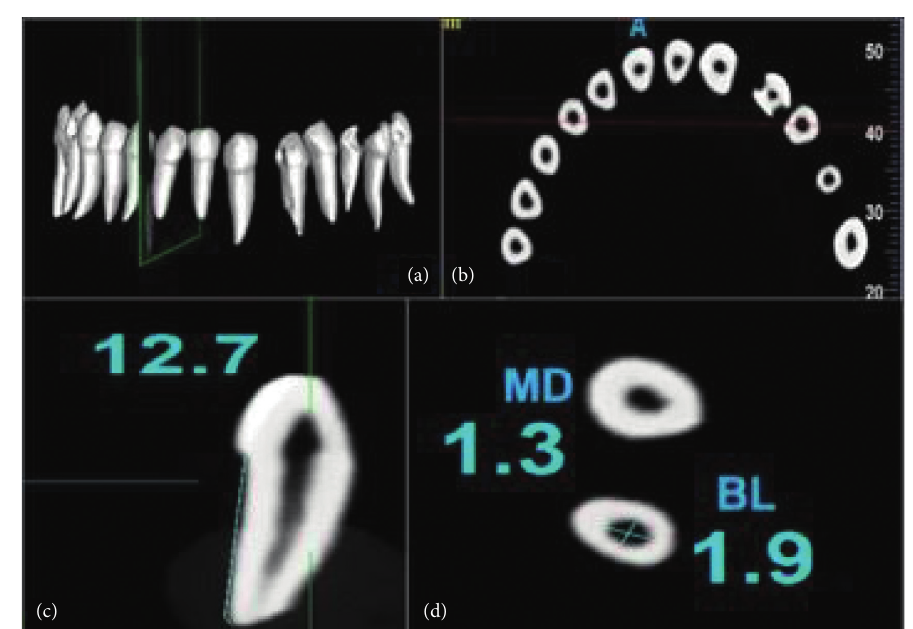
Figure 2: (a) Number of roots. (b) Number of root canals. (c) Length of root. (d) Width of root